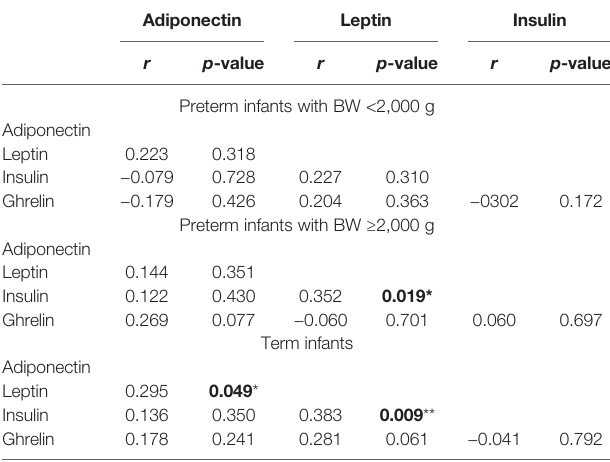
TABLE 2 | Interrelationship between the metabolic hormones in preterm and term infants. Adiponectin Leptin